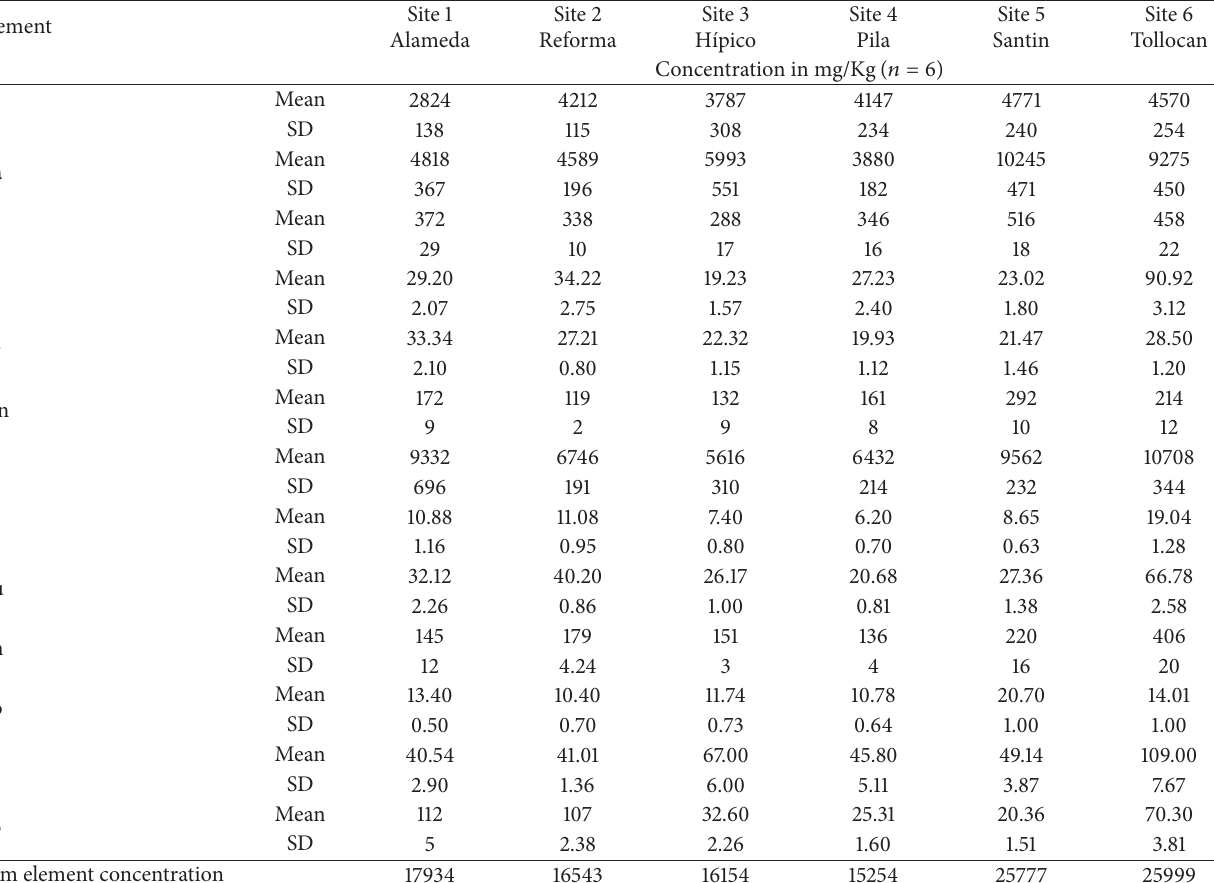
Table 4: Mean concentrations (mgkg − 1 ) of elements in Fabronia ciliaris.